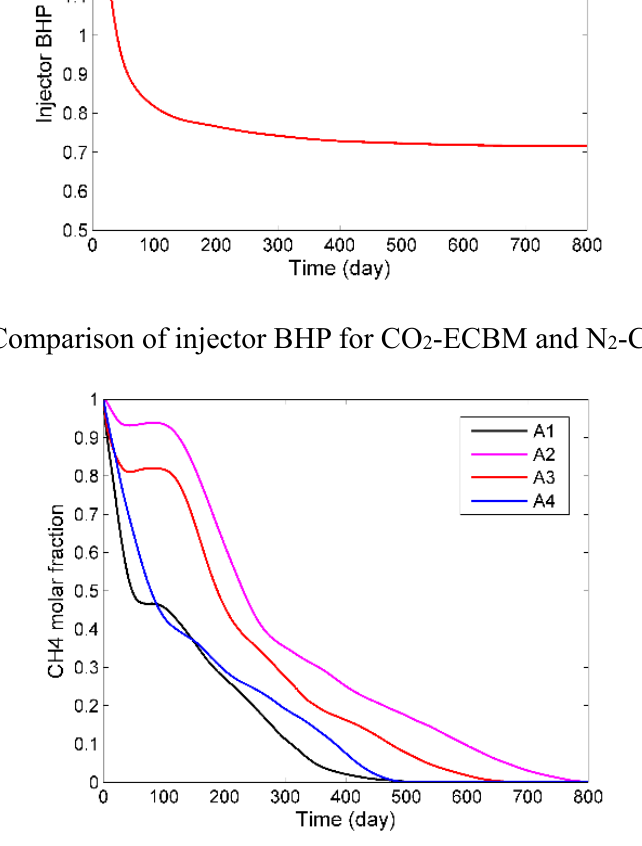
Figure 23. CH 4 molar fraction for producers with N 2 -CO 2